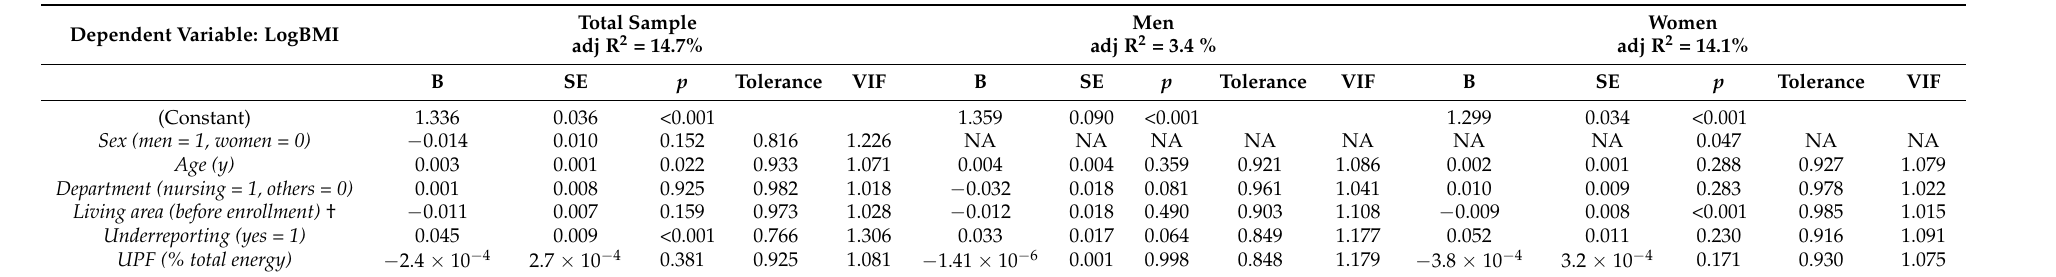
Table 6. Linear regression analysis for BMI (log) in the total sample, men and